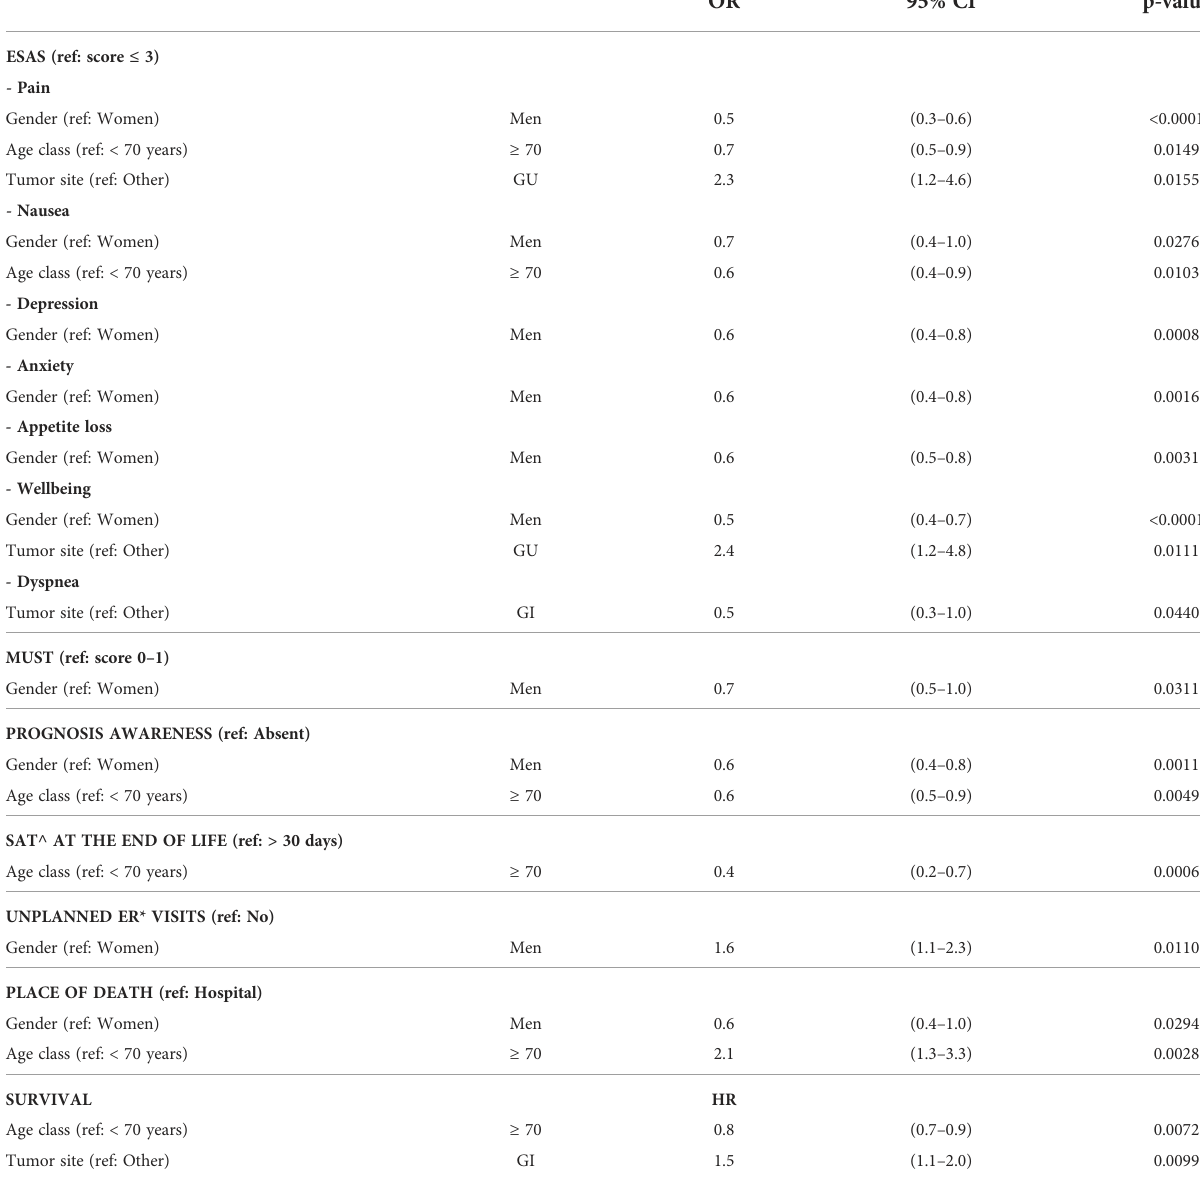
TABLE 4 Results by multivariate analysis.